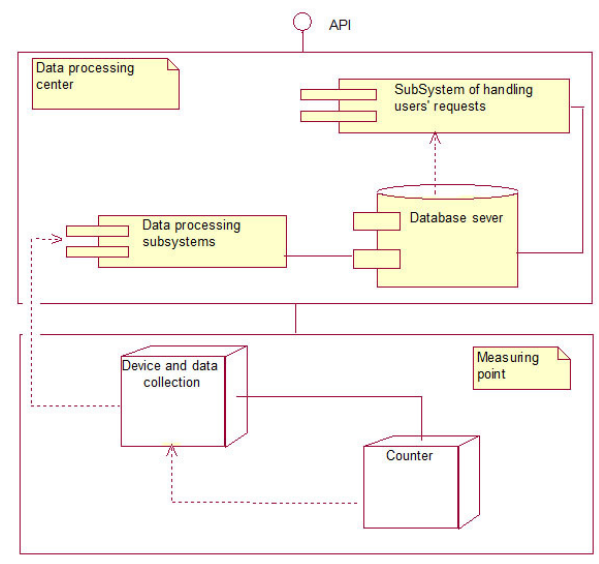
Figure 1: Diagram of information system deployment with one database